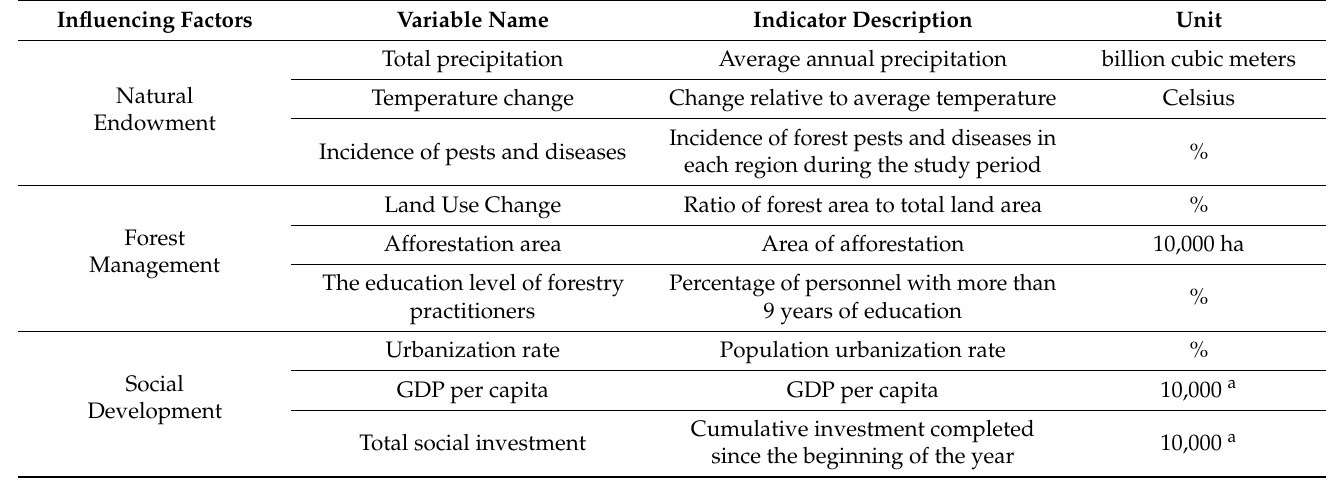
Table 2. Indicators of influencing factors for the forest carbon sink